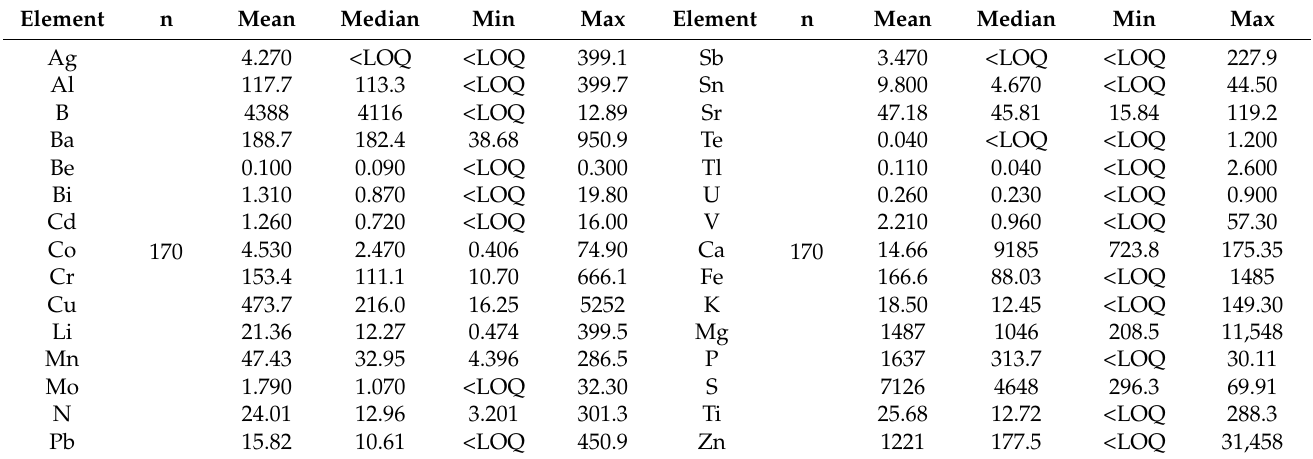
Table 2. Basic statistics for determined elements for all whisky samples (n = 170) [ µ